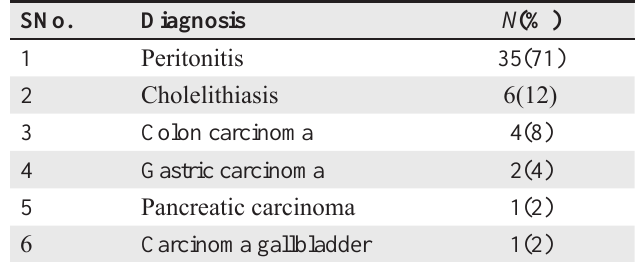
Table 1 : Frequency distribution of diagnosis.